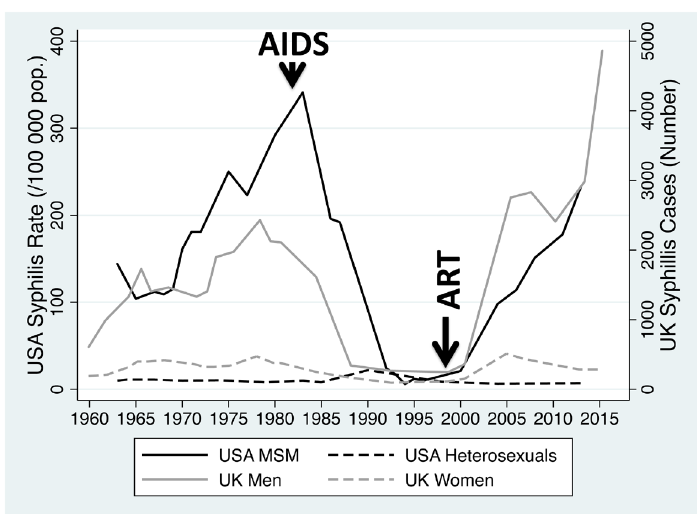
Figure 1. Incidence of primary/secondary syphilis in the United States (MSM and heterosexual men; cases per 100 000/ population) between 1963–2013 and cases of primary, secondary and early latent syphilis diagnosed in men and women in England and Wales between 1950 and 2015. Beginning of ‘AIDS’ epidemic and introduction of ‘ART’ – antiretroviral therapy – indicated with